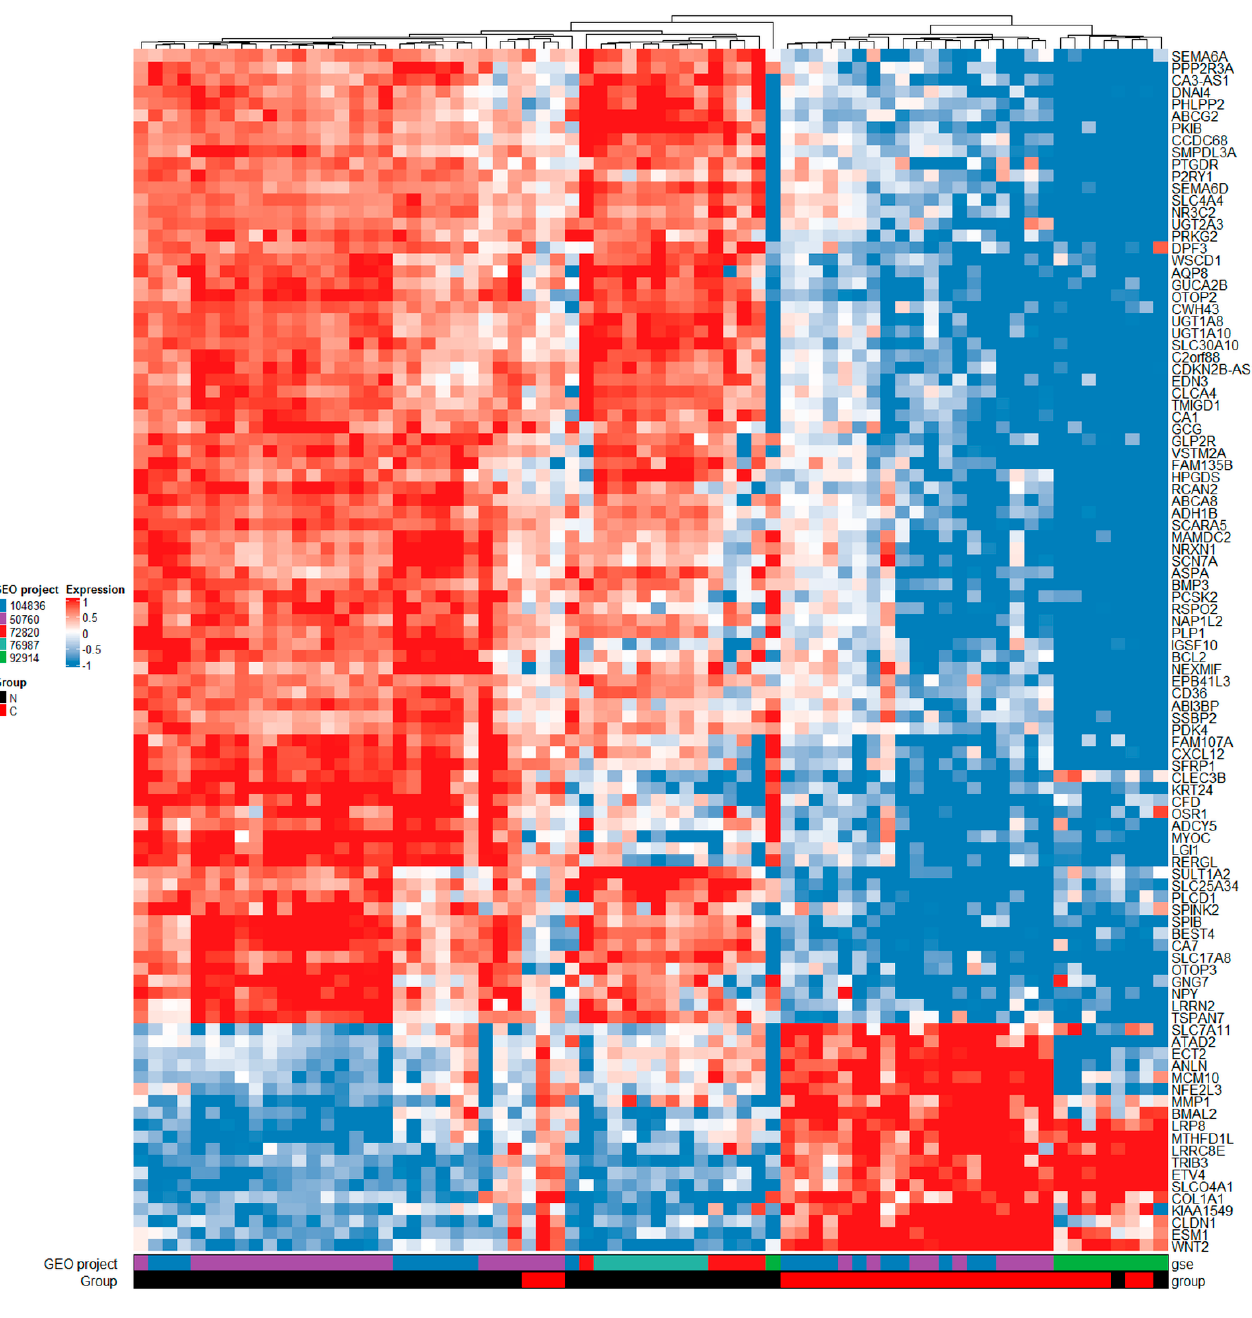
Figure 2. Heatmap of top 100 DEGs between normal tissue and carcinomas. Legend: GEO, gene expression omnibus; GSE, gene expression omnibus series; group N, normal tissue; group C, carcinoma tissue; gene names are shown on the right side of the heatmap; downregulation is associated with blue color, no difference in expression is associated with white color, and upregulation is associated with red color.